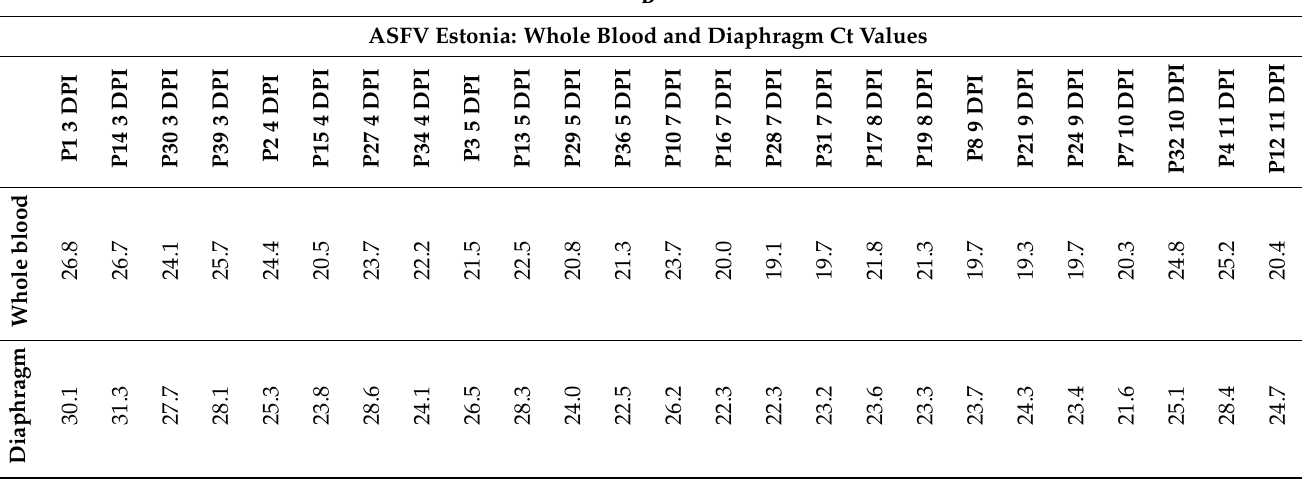
Groups of pigs ( n = 14–39) were infected oronasally with 1 × 10 5 TCID 50 ASFV Malawi LIL 18/2 ( A ) or 2 × 10 5 TCID 50 ASFV Estonia 2014 ( B ), and on the final dpi of each pig, the muscles were collected, and the extracted meat exudate was assessed for ASFV genomic material by real-time PCR. The results are presented together with those of the whole blood samples of the same dpi. Dead pigs were excluded from the